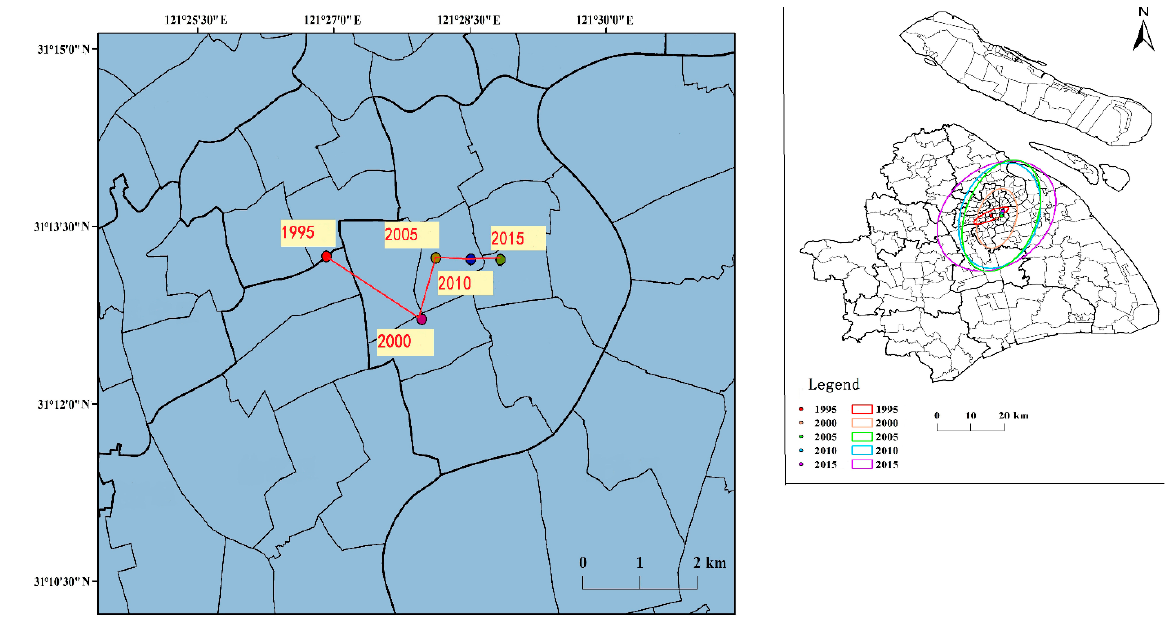
Figure 5. The barycenter distribution ( left ) and standard deviational ellipse (SDE) map ( right ) of luxury hotel locations from 1995 to 2015.